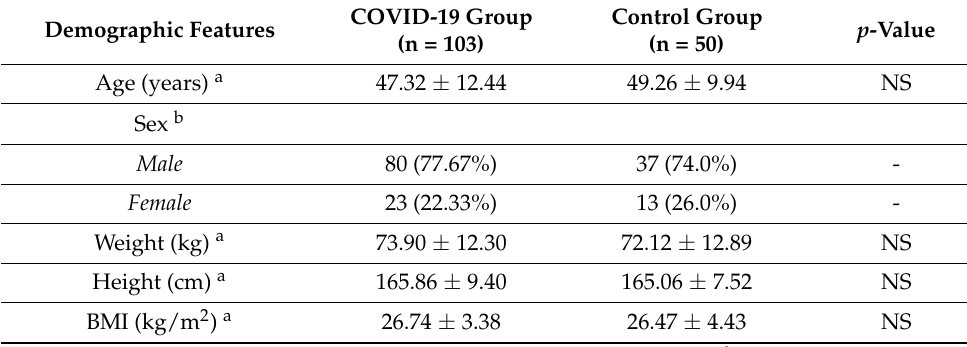
Table 1. Demographic features of COVID-19 positive group compared with control group.